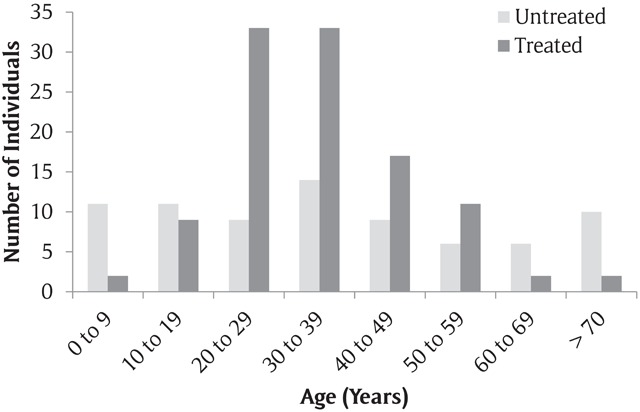
Age distribution of respondents with treated and untreated abdominal surgical conditions.